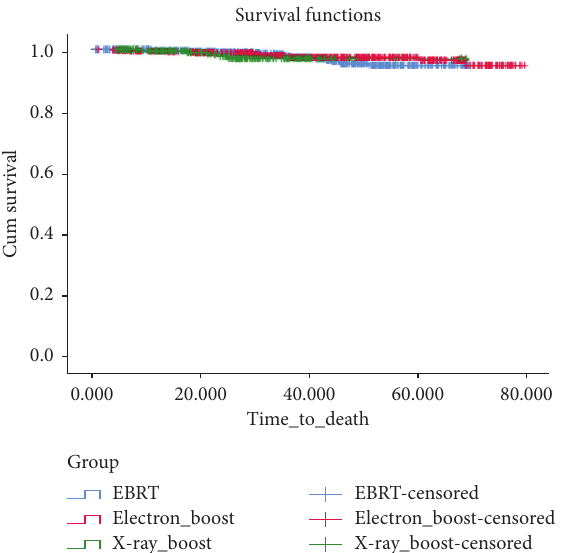
Figure 1: Cumulative incidence of disease-free survival in the boost groups in comparison with EBRT.